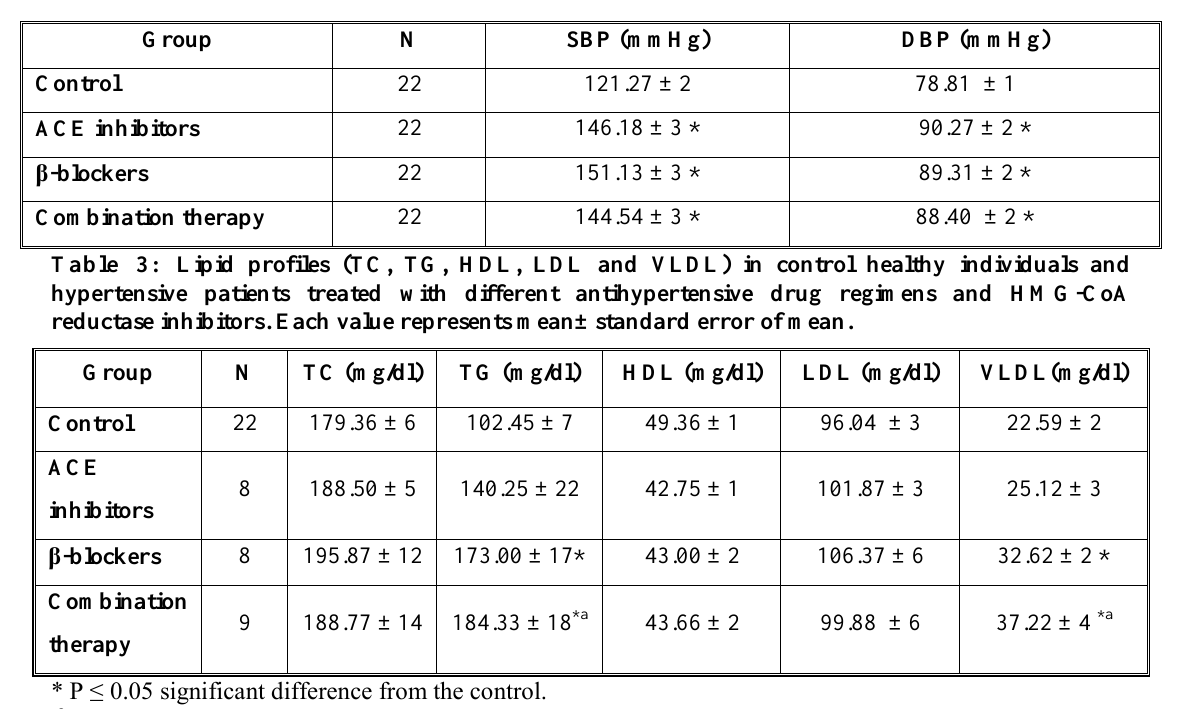
Table 2: SBP and DBP in control healthy individuals and hypertensive patients treated with different antihypertensive drug regimens. Each value represents mean± standard error of mean. * P ≤ 0.05 significant difference from the control.